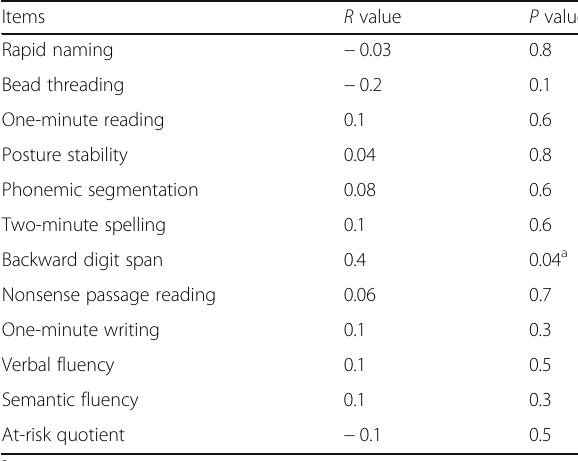
Table 2 Correlation analysis between ubiquinone levels and the Dyslexia Assessment Test subtests and its at-risk quotient in the specific learning disorder